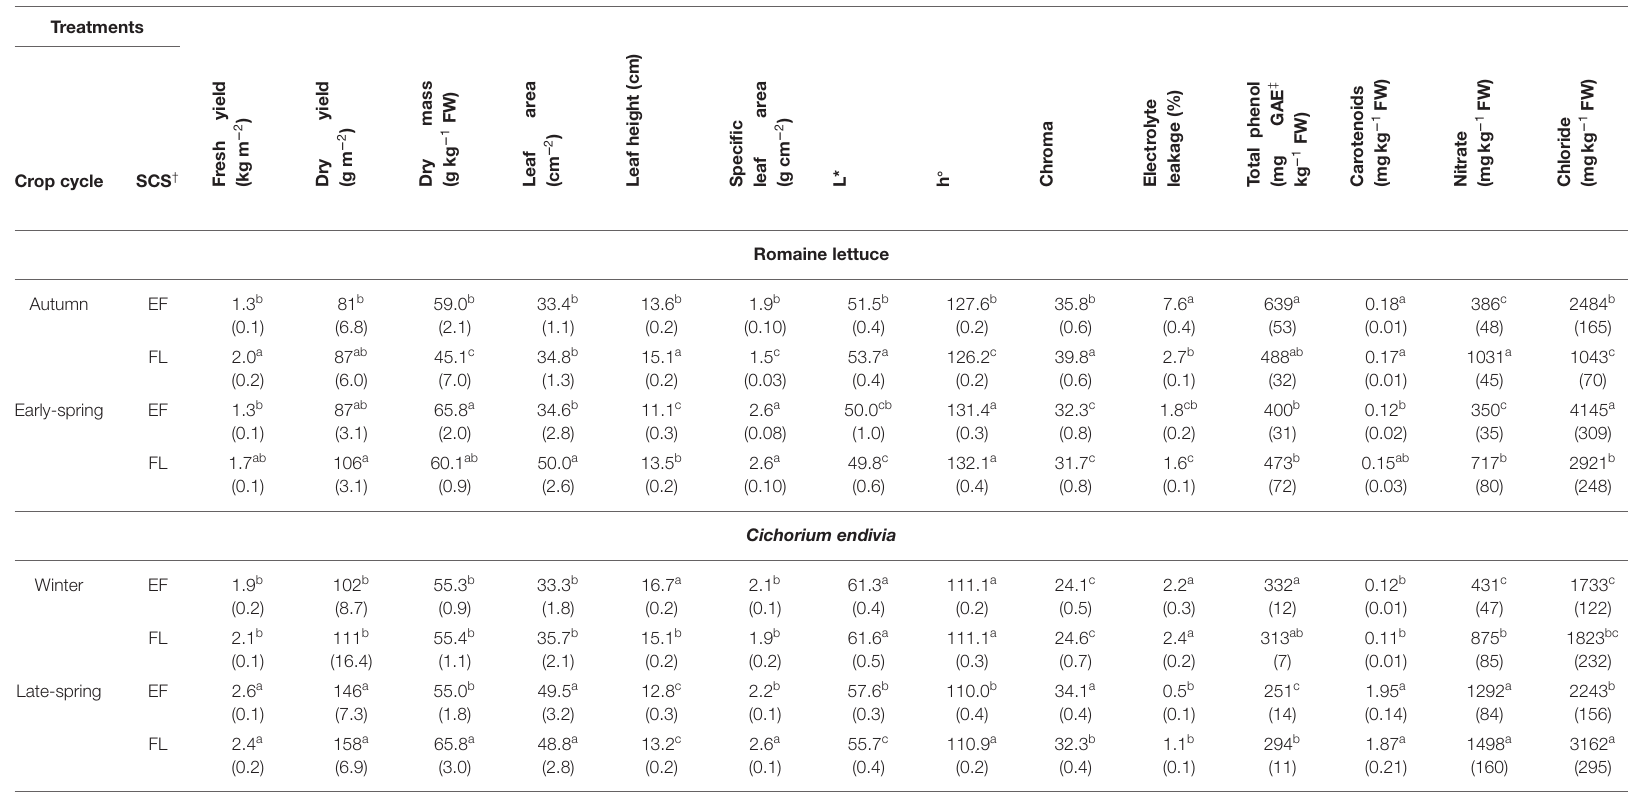
TABLE 9 | Effect of the crop cycle and soilless cultivation system (SCS) on yield, bio-morpho-physiological traits, nitrate, chloride and antioxidant compound concentrations of romaine lettuce (autumn/early-spring cycles) and C. endivia (winter/late-spring cycles) leaves, with the standard error of mean in brackets.